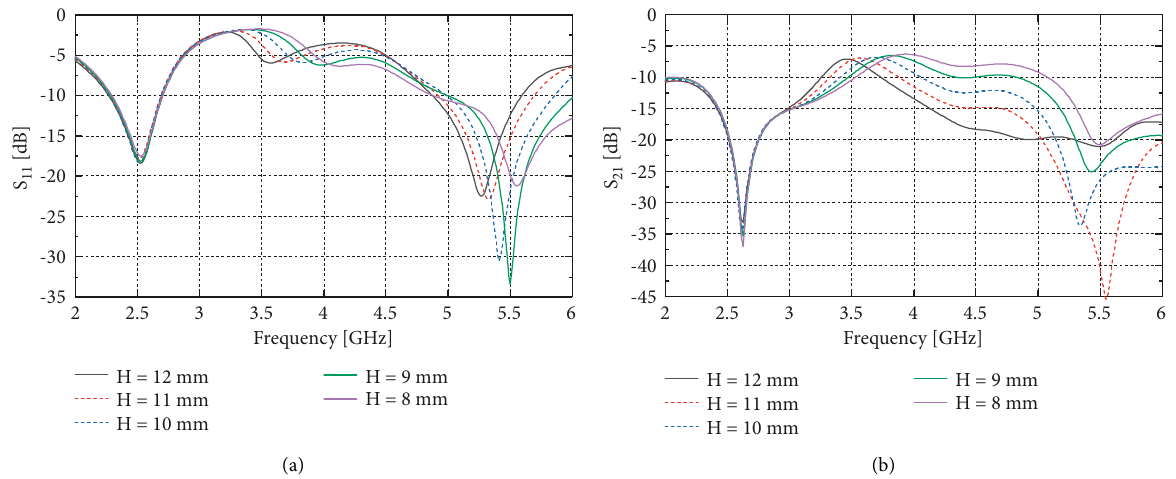
Figure 6: S-parameters of antenna#1 with different heights of the NL: (a) S